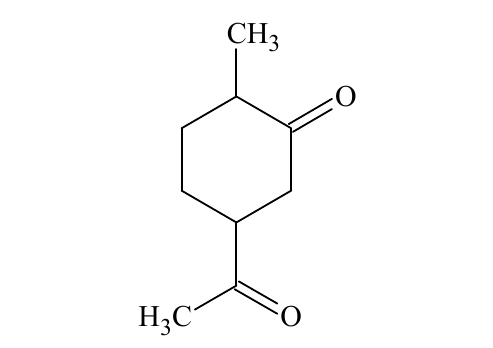
Figure 7. Chemical structure of